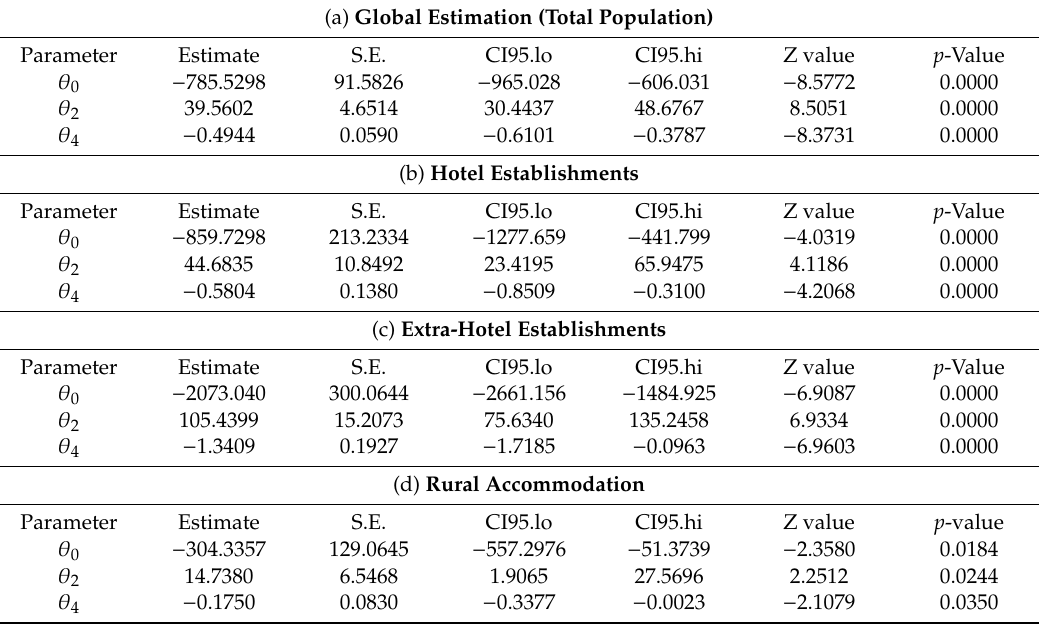
Table 7. Estimation of model (6) λ ( u ,x ) = exp ( θ 0 + θ 2 y + θ 4 y 2 ) . (a) Global Estimation (Total